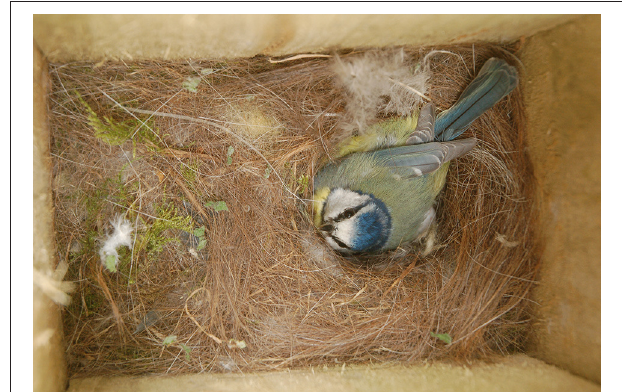
FIGURE 1 | Female blue tit incubating eggs (Photo: Mark C. Mainwaring).